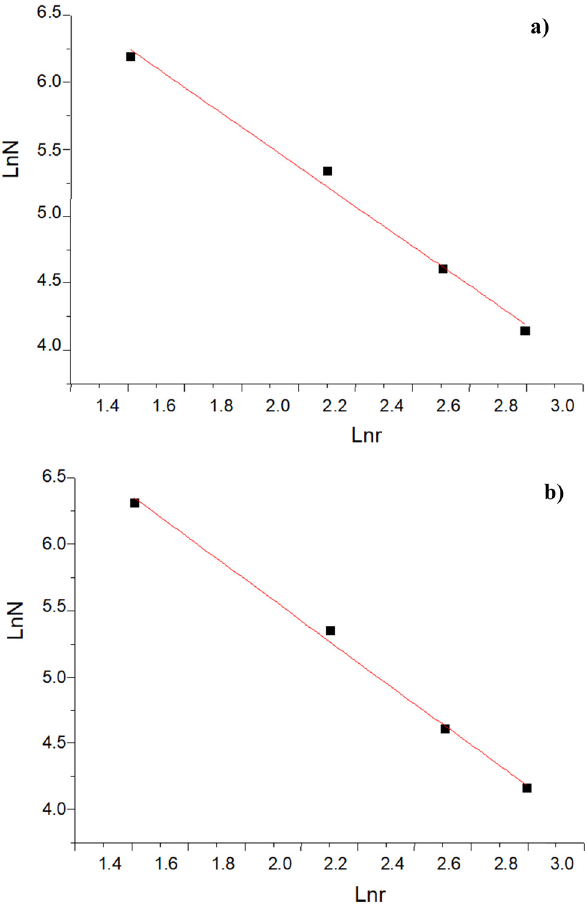
Figure 16. Following the same procedure, the particle boundary line and fractal dimension D were obtained by means of box - counting method, as shown in Figures 17 and 18, and the corresponding results were listed in Table 8.